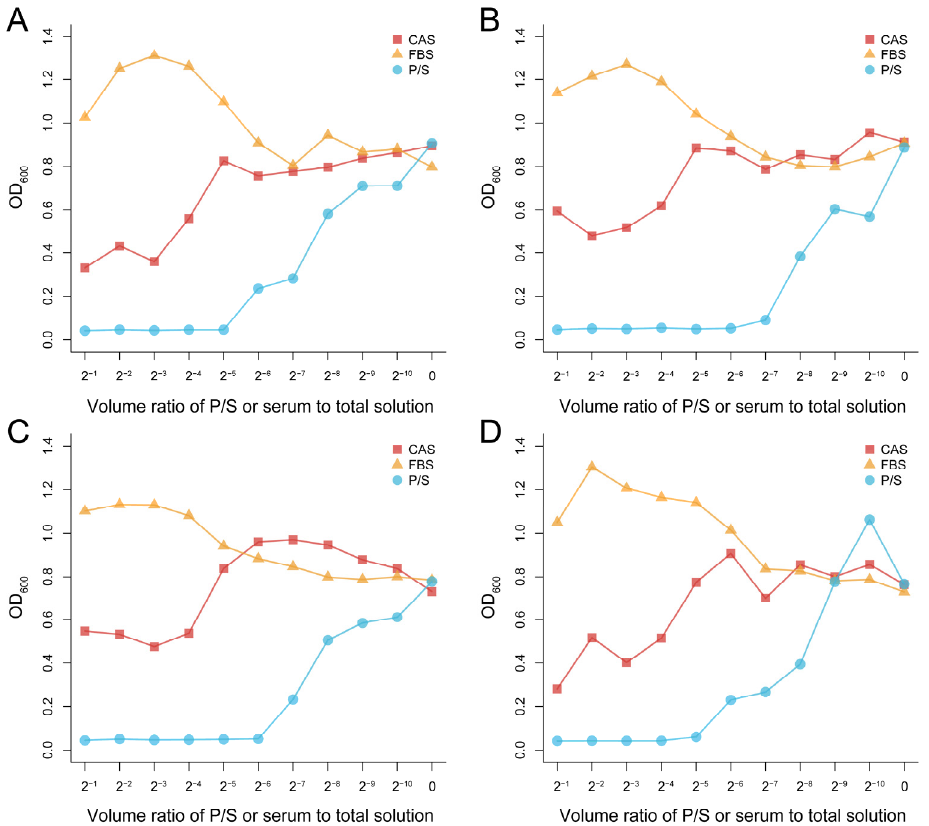
Figure 1. Antibacterial effect of Chinese alligator serum against Klebsiella pneumoniae ( A ), Staphylococcus aureus ( B ), Escherichia coli ( C ), and Pseudomonas aeruginosa ( D ) at different concentrations. There is 100 μ L of the bacteria solution and 100 μ L of the serum or P/S in well 1. In wells 2 to 10, the concentration of serum or P/S was reduced to 1/2 of the previous well consecutively. No serum or P/S was added to well 11, only the bacterial solution and culture medium. All of the bacterial solutions in the plates had reached the platform stage. CAS: Chinese alligator serum, FBS: fetal bovine serum, P/S: Penicillin-Streptomycin Solution.